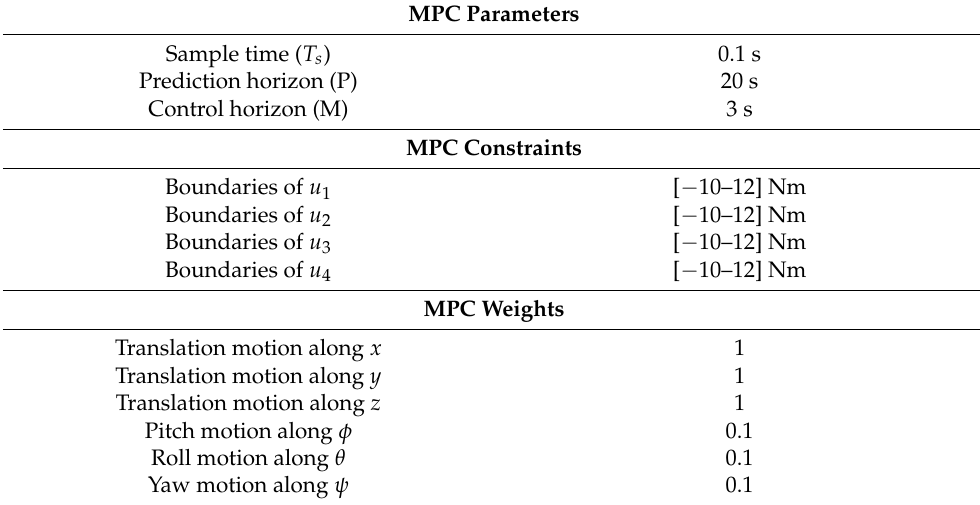
Table 3. The required parameters of MPC for the Tello